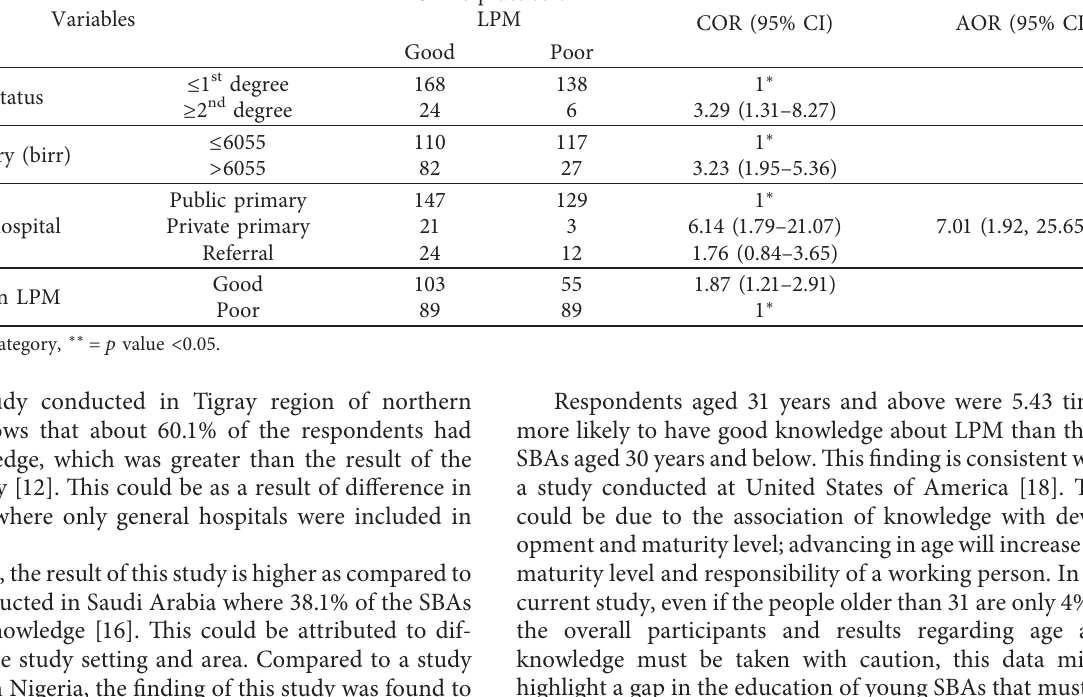
Table 5: Factors associated with practice on LPM among SBAs working at hospitals in Gondar zones, northwest Ethiopia, 2019. Variables